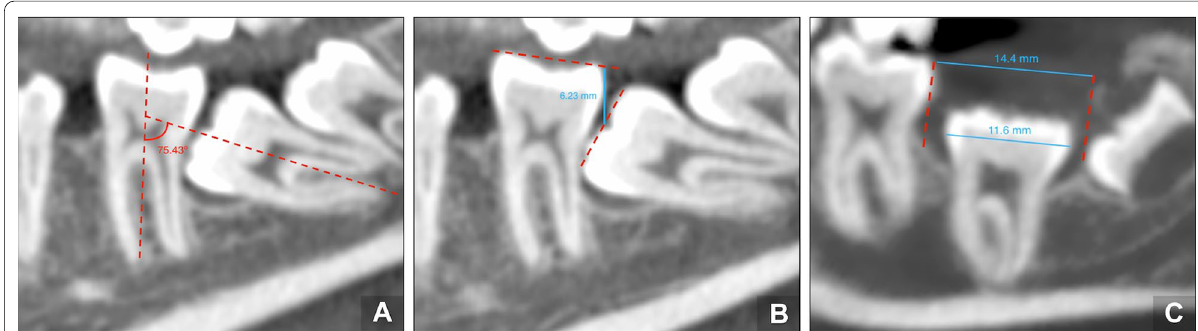
Fig. 3 Scan measurements of the impacted/retained M2: a molar angulation. b degree of infraocclusion. c lack of space for